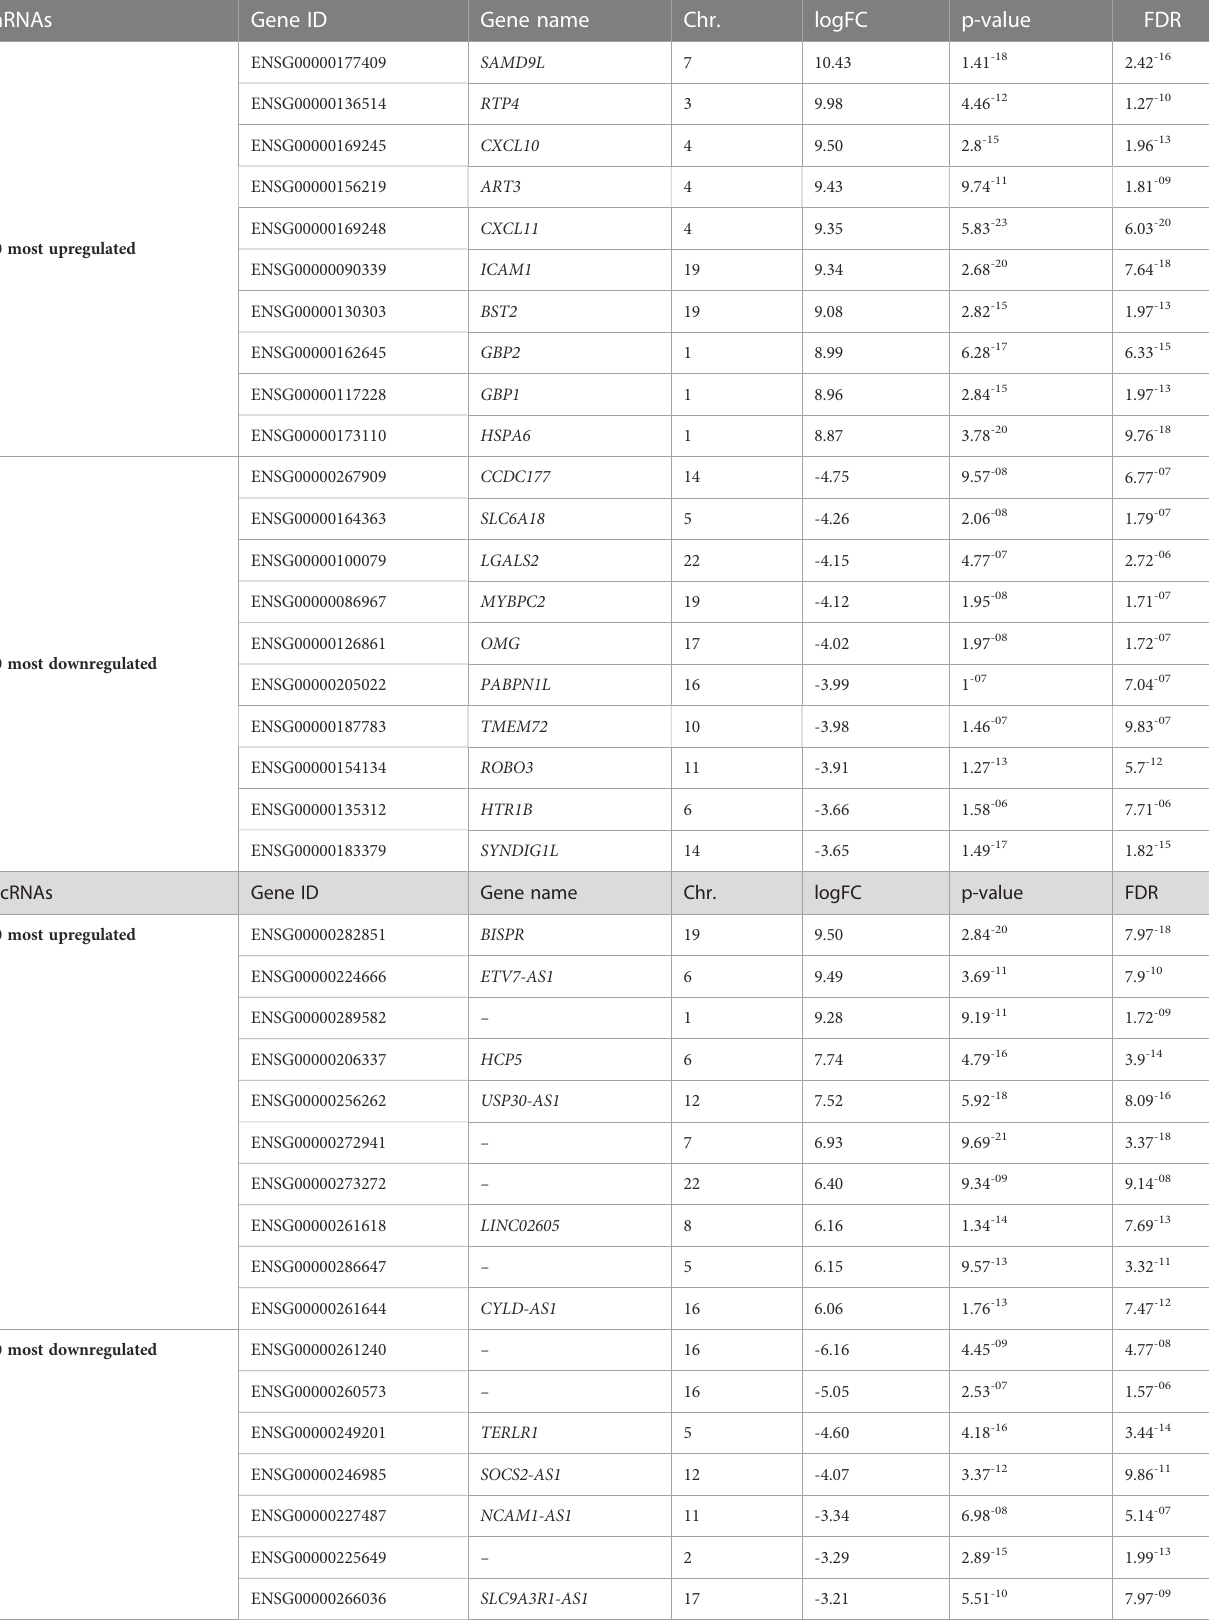
TABLE 1 Ten most up- and downregulated mRNAs and lncRNAs ranked based on log-fold changes (logFC) from RNA sequencing of untreated EndoC- b H5 cells or cells exposed to cytokines (50 U/mL IL-1 b , 1000 U/mL IFN g and 1000 U/mL TNF a ) for 48 h.